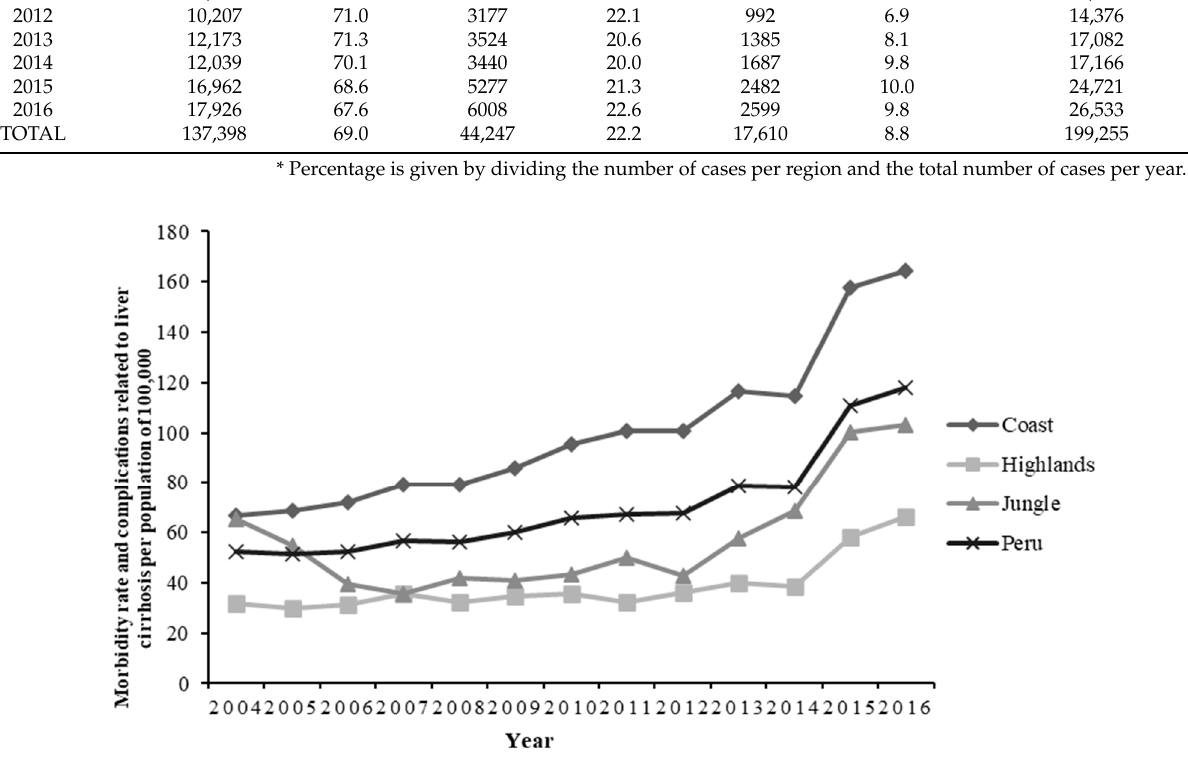
Figure 1. Trends of morbidity rate and complications related to liver cirrhosis according to region and registered year of death for the period 2004–2016. Table 2. Morbidity and complications of liver cirrhosis by region: Comparing periods of 2004–2005 and